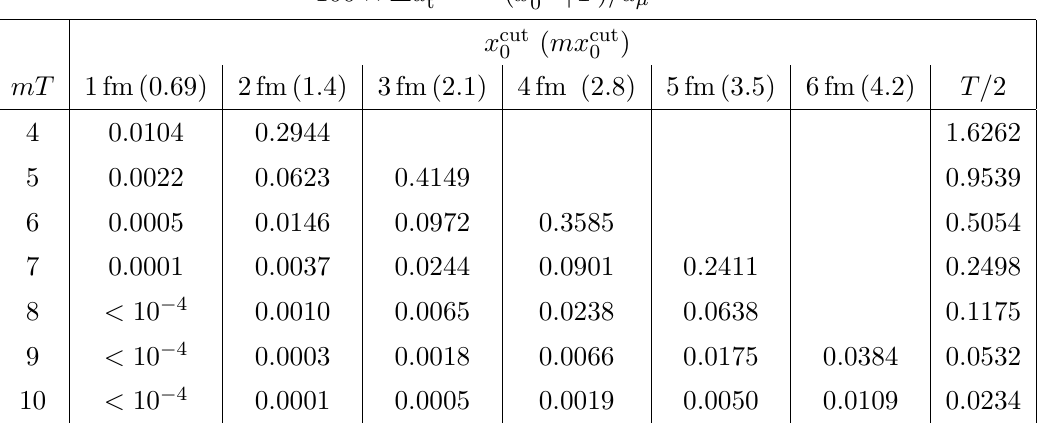
Table 3 . Numerical estimates of the single-particle contribution to (cid:1) a WP term), normalized to a HVP,LO = 700 (cid:2) 10 (cid:0) 10 for various (cid:12)xed values of the cuto(cid:11) on the x 0 integral, (cid:22) denoted by x cut . These values, given by eq. (2.42), depend only on the pion mass and muon mass, 0 taken as m = 137 MeV and m (cid:22) = 106